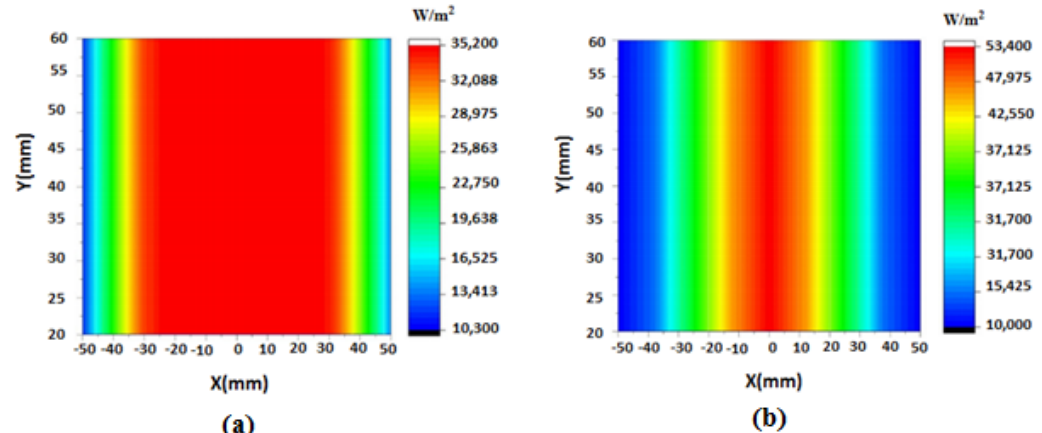
Figure 17. Flux distribution of ( a ) planar concentrator ( b ) parabolic trough concentrators [24]. Reprinted from G. Wang et al., Experimental and optical performances of a solar CPV device using